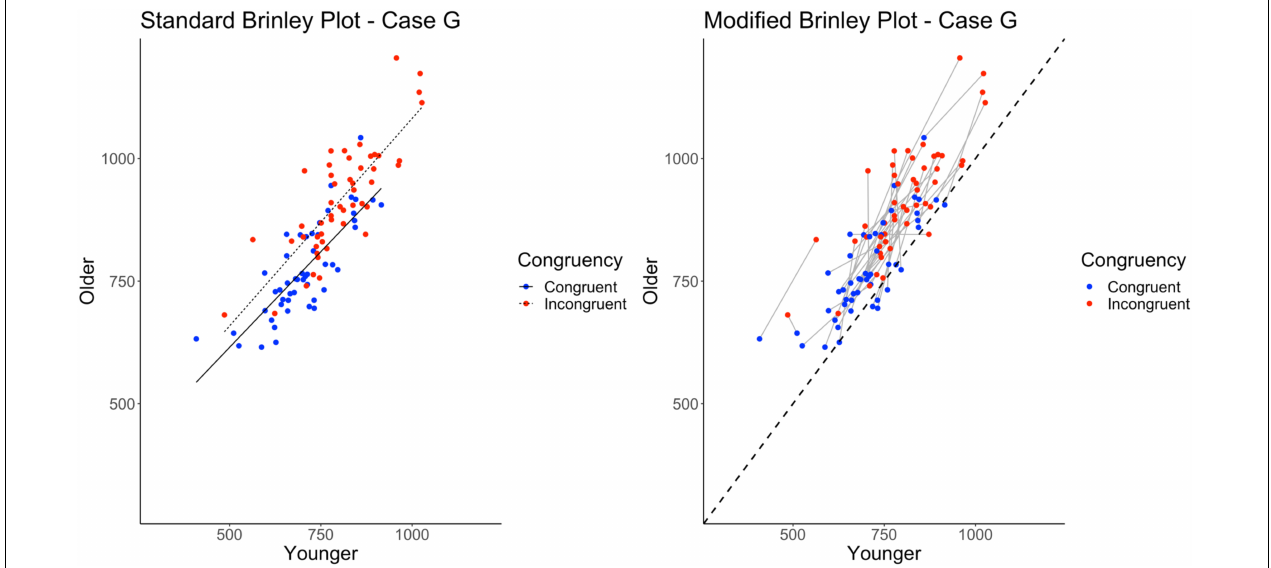
FIGURE 9 | Standard and modified Brinley plots—Case G data. Standard and modified Brinley plots (left and right, respectively) for the Case G simulated data which was simulated such that study interaction magnitudes differed randomly. Means (SD) used for Case G were as follows: Young Congruent = 700 (150), Young Incongruent = 800 (150), Old Congruent = 750 (200), Old Incongruent = 900